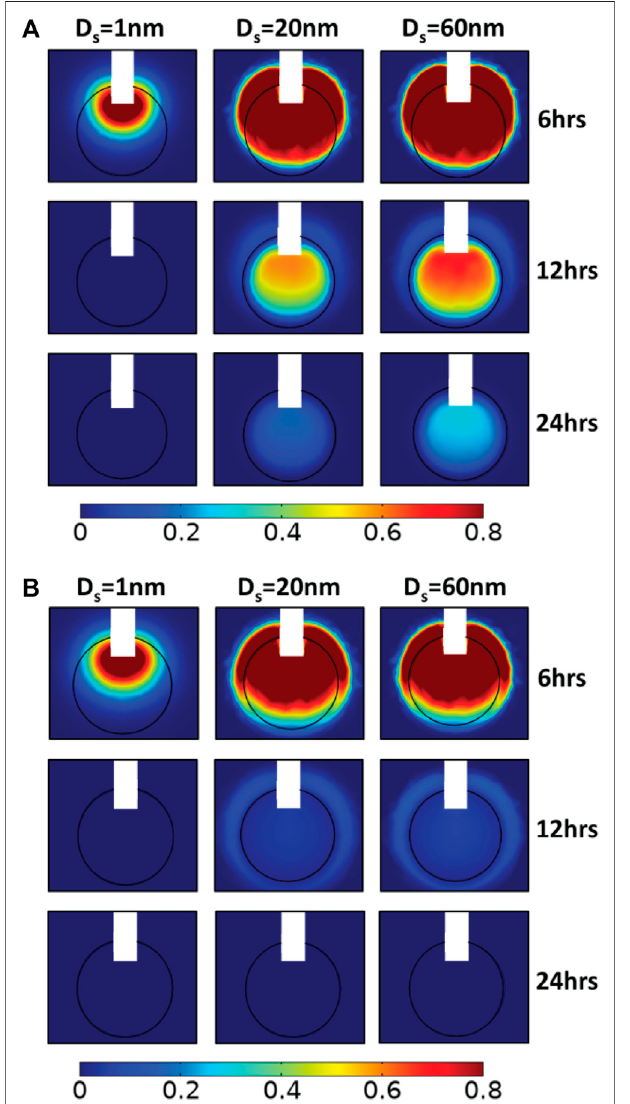
FIGURE 4 | Simulated drug concentration with different hydraulic conductivities of the tumor interstitial space. A sagittal view in the center of tumor tissueshowingthespatialdistributionofdrugconcentrationfor100 nm pore diameter of vascular walls and for different diameters of the therapeutic agent, D s : 1, 20, and 60 nm (columns) in three snapshot: 6, 12, and 24 h (rows), and for different hydraulic conductivities of the tumor interstitial space, k : (A) 2 × 10 − 14 m 2 /(Pa s) and (B) 2 × 10 − 12 m 2 /(Pa s). Drug concentration is normalized by division with the reference value entering the catheter.